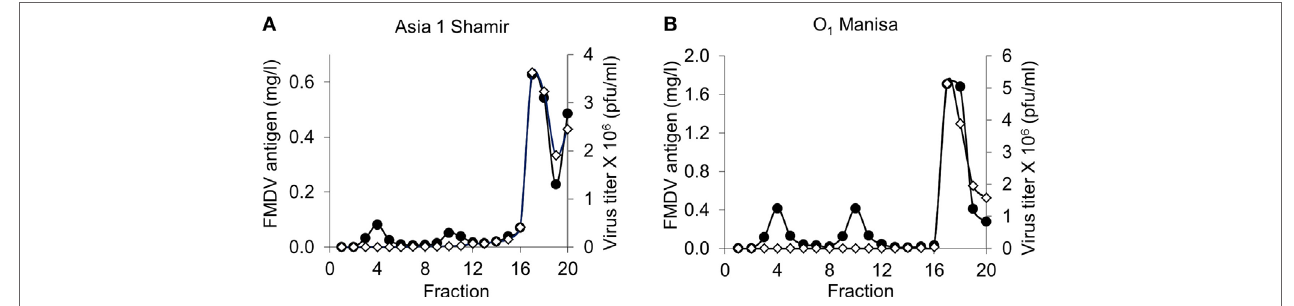
FigUre 3 | Specificity of double antibody sandwich (DAS) enzyme-linked immunosorbent assays (ELISAs) for infectious foot-and-mouth disease virus (FMDV) particles fractionated by sucrose density gradient (SDG). Infectious virus of FMDV strain Asia 1 Shamir (a) or O 1 Manisa (b) was fractionated on SDG. Each fraction was analyzed for infectious FMDV titer (open diamonds) or the FMDV antigen concentration (closed circles). FMDV antigen concentration was measured by M3 ELISA on samples that were first acidified for conversion into 12S A particles against a 12S A standard. Fraction 1 corresponds to top of